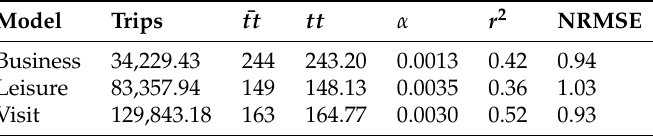
Table 3. Gravity model